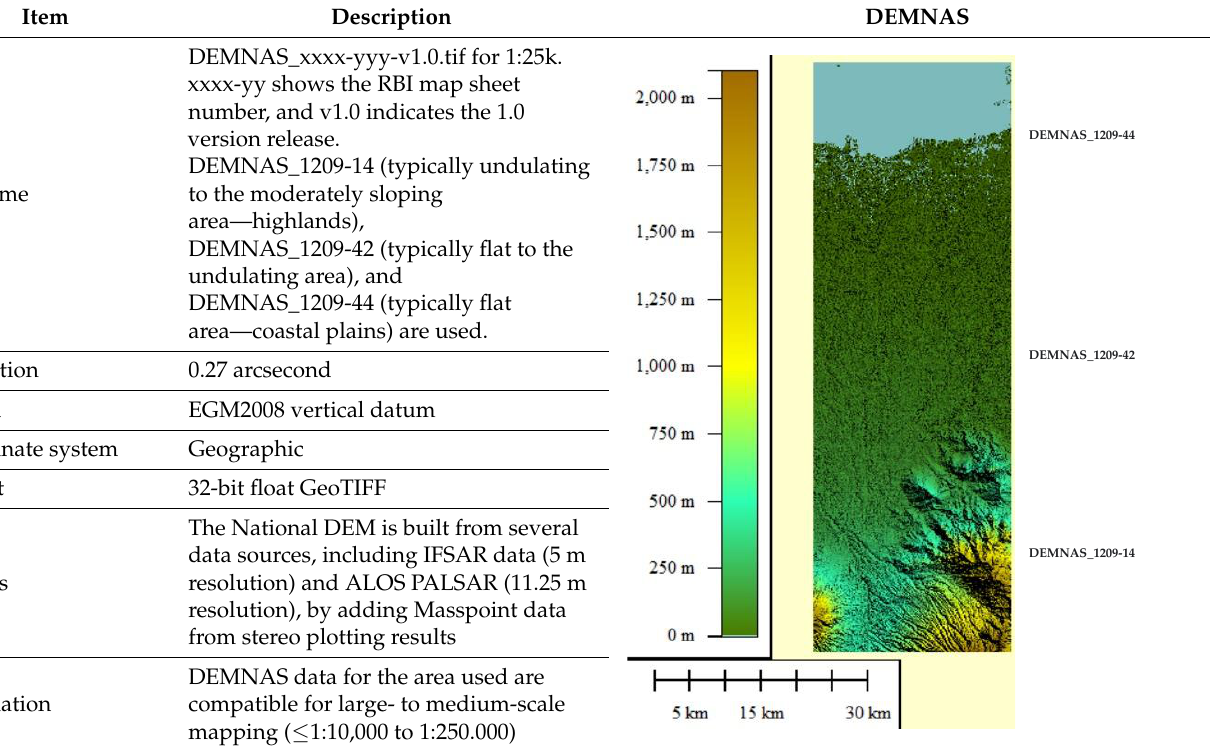
Table 3. Data Description.